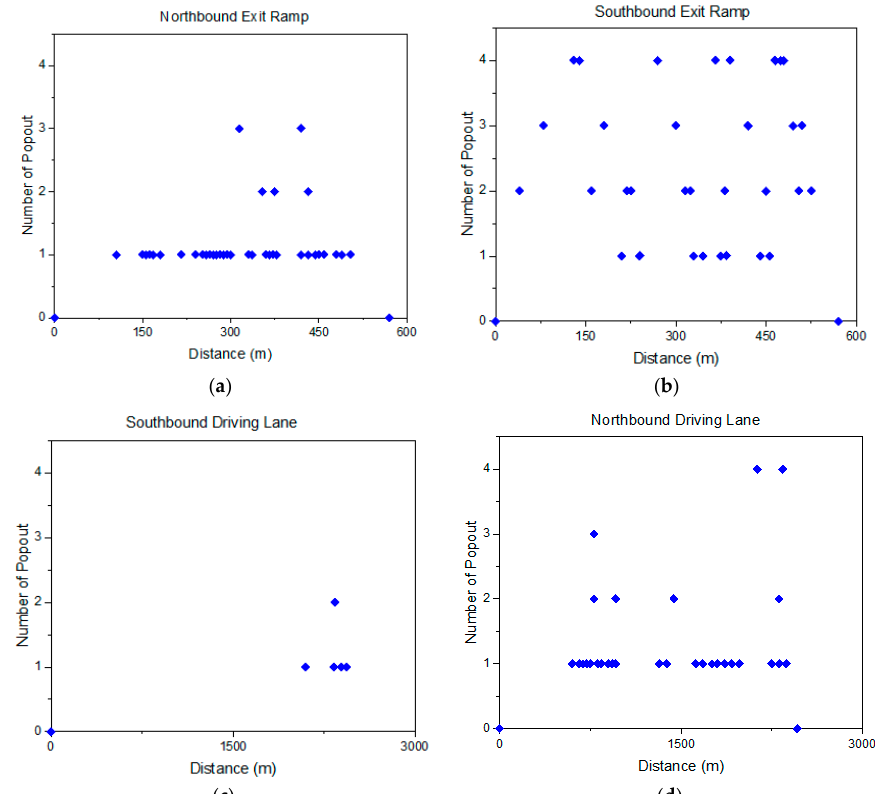
Figure 5. Clay ball distribution within ( a ) southbound exit ramp, ( b ) northbound exit ramp, ( c ) Figure5. Clayballdistributionwithin( a )southboundexitramp,( b )northboundexitramp,( c )southbound southbound driving lane, and ( d ) northbound driving lane. driving lane, and ( d ) northbound driving